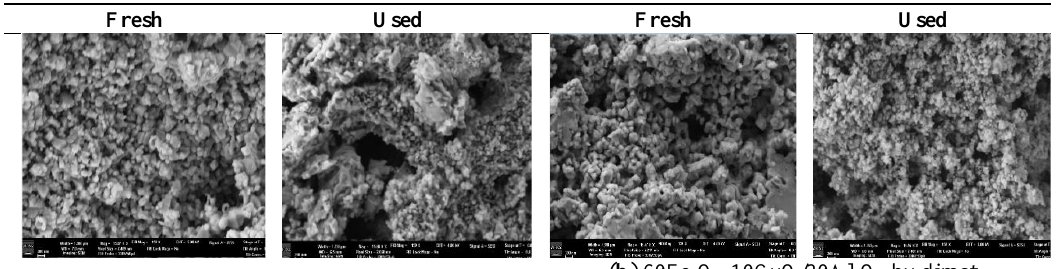
Table 1. Both experiments were conducted from an ambient temperature to 800 ◦ 10 C / min purging with nitrogen gas at 60 ml / min. Sand was used in the place of an oxygen carrier